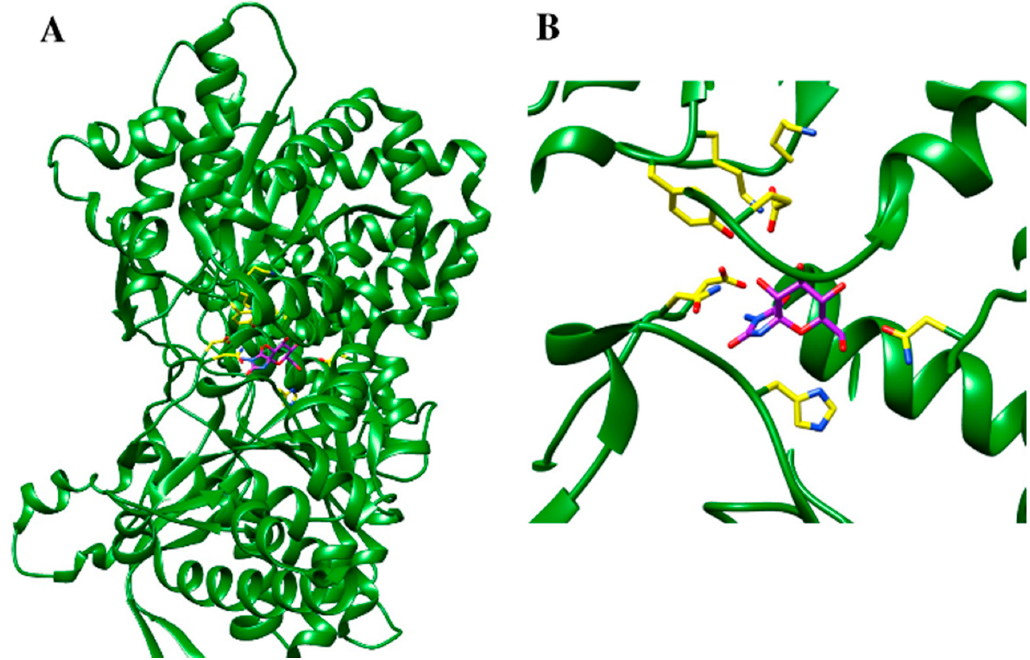
Figure 5. ( A ) Glycogen phosphorylase complex with its inhibitor (3-amino-8,9,10-trihydroxy-7- hydroxymethyl-6-oxa-1,3-daza-spiro[4.5]decane-2,4-dione). ( B ) Magnified representation of the binding site with inhibitor. The enzyme is represented as a secondary structure and shown in green, residues at catalytic site as well as an inhibitor are represented as ball and stick and highlighted in yellow and purple, respectively [168].